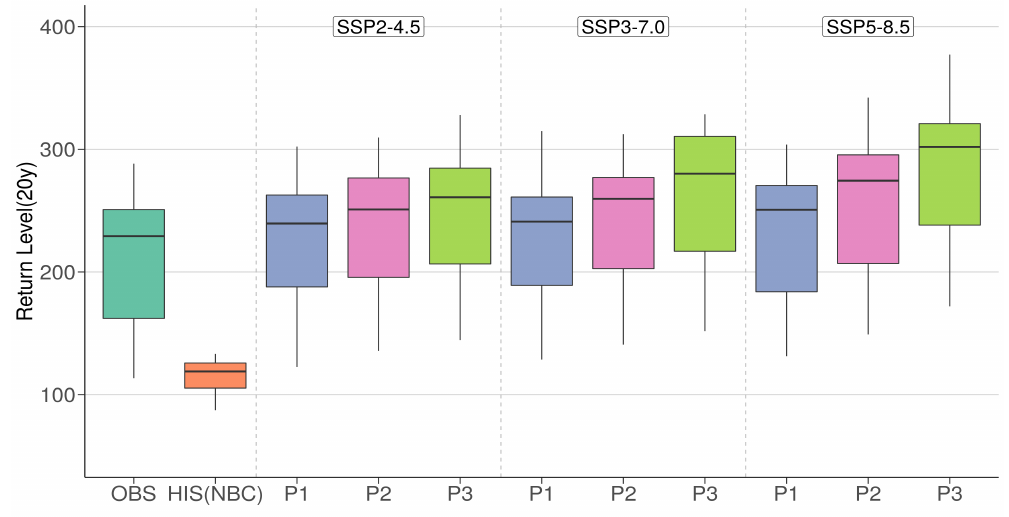
Figure 7. Schematic boxplots of 20-year return levels (unit: mm) of the annual maximum daily precipitation averaged over 46 grids in the Korean peninsula for the future periods, i.e., P1 (2021–2050), P2 (2046–2075), and P3 (2071–2100), under the SSP2-4.5, SSP3-7.0, and SSP5-8.5 scenarios. OBS and HIST(NBC) indicate the observations and the historical data without a bias correction. The boxplot for P0 represents the bias-corrected historical data.